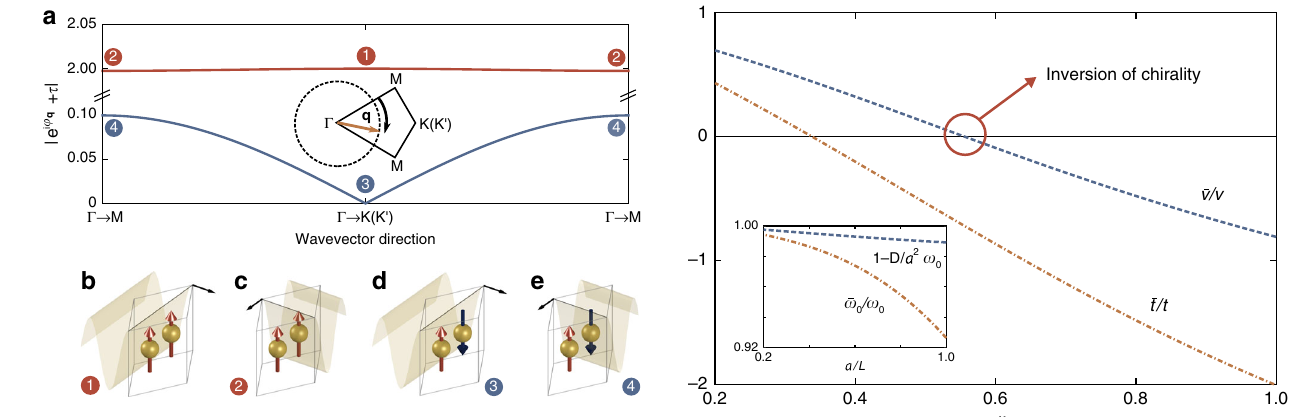
Fig. 3 Non-trivial winding in the light – matter interaction. a Dependence of the magnitude of the light – matter coupling constant j Λ the direction of q from Γ − M to Γ − K(K ′ ) (see inset), for the upper (red line) and lower (blue line) quasistatic bands. Plots obtained with | q | = | K |/ 2. b – e Schematics of the bright ( ↑↑ ) and dark ( ↑↓ ) con fi gurations of the two sublattices interacting with the photonic mode which is indicated by the fi eld pro fi le. Panels b and d represent the crossings labeled ‘ 1 ’ and ‘ 3 ’ in Fig. 2 along the Γ − K(K ′ ) directions, respectively, while c and e represent the crossings labeled ‘ 2 ’ and ‘ 4 ’ along the Γ − M directions,